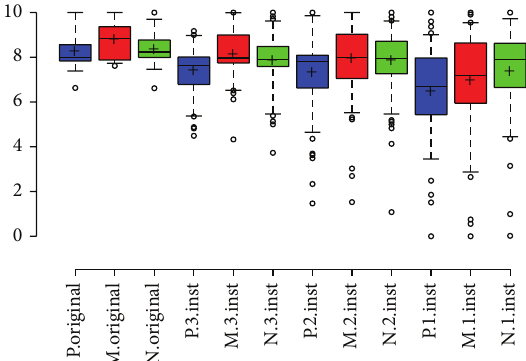
Figure 1: NH listeners without CI simulation enjoyment by number of instruments. NH listeners preferred the original music sample compared to modified segments comprised of a single instrument, two instruments, or three instruments. P: pleasant, N: natural, M: sounds like music, and Inst: instruments. Center lines show the medians, box limits indicate the 25th and 75th percentiles, whiskers extend to 5th and 95th percentiles, outliers are represented by dots, and crosses represent sample